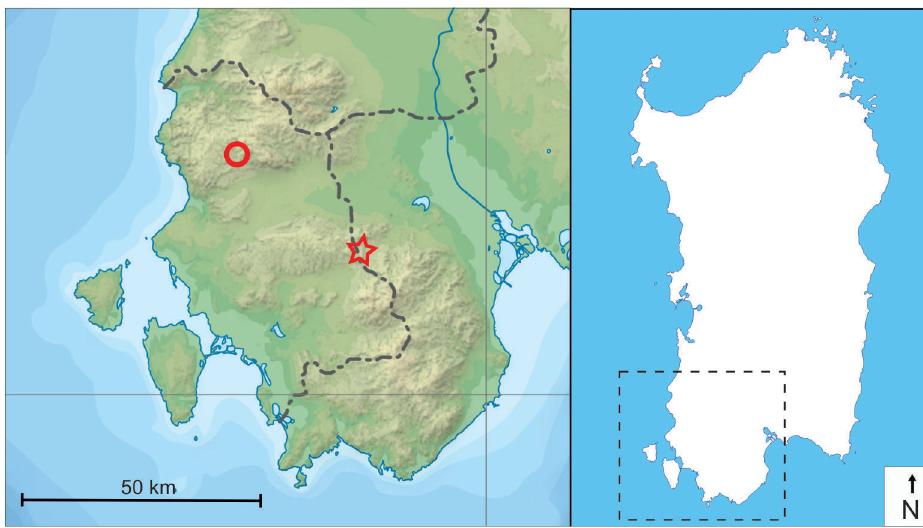
Fig. 5. Localities where Endogeophilus ichnusae gen. et sp. nov. has been collected, in the Sulcis- Iglesiente, Sardinia. The type locality is indicated by a